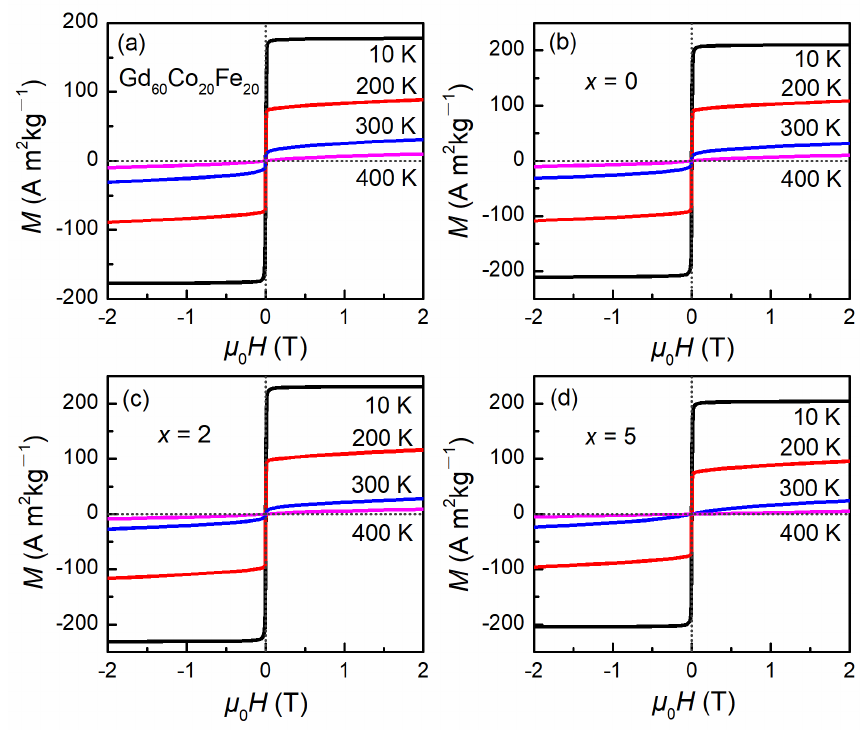
Figure 6. Magnetic hysteresis loops of ( a ) Gd 60 Co 20 Fe 20 and ( b – d ) (Gd 0.6 Co 0.2 Fe 0.2 ) 95 B x Si 5−x ( x = 0, 2, 5) amorphous alloys at different temperatures.